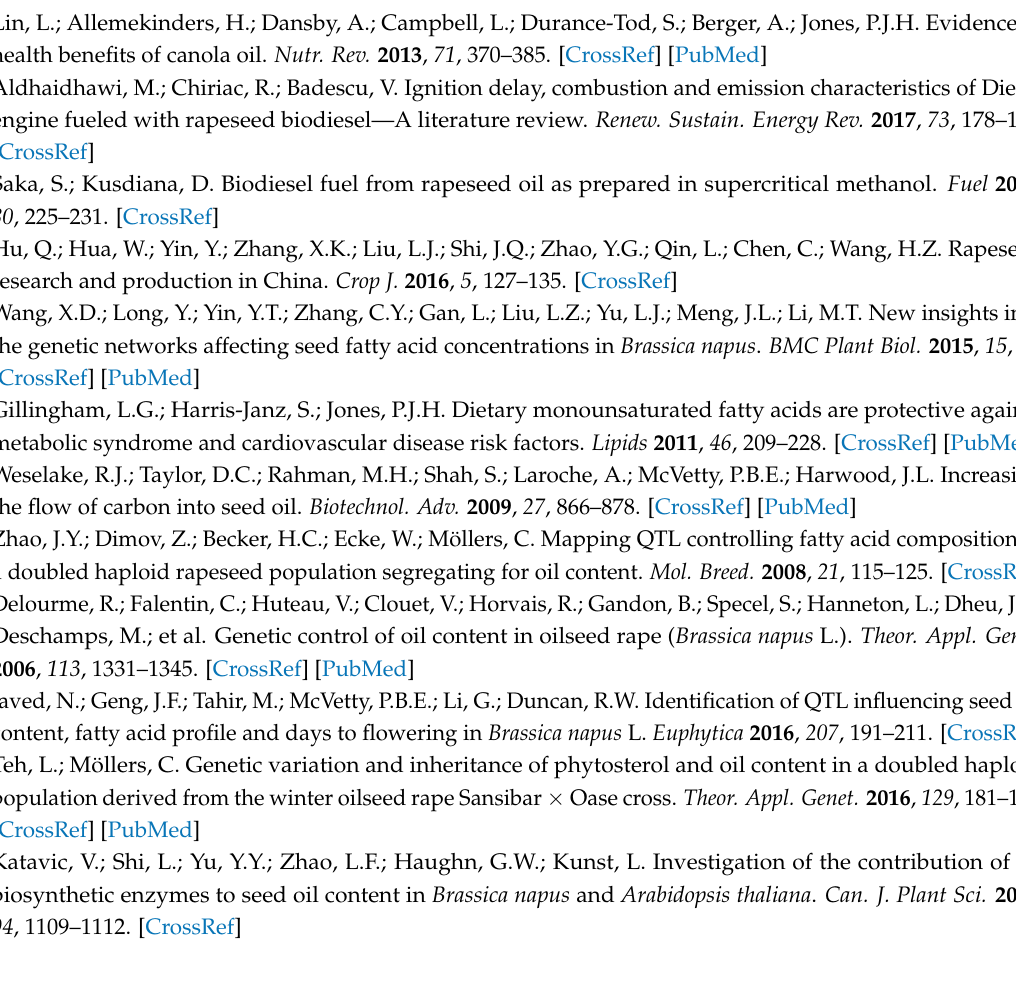
Figure S1: PCR analysis of putative transformants of GmDof4 , Figure S2: PCR analysis of putative transformants of GmDof11 , Figure S3: Homology of the accD gene promoters in B . napus and A . thaliana , Table S1: Amplification primers used for Semi-quantitative and quantitative RT-PCR, Table S2: Composition of the major fatty acids in GmDof4 and GmDof11 transgenic seeds, Table S3: the Dof genes in B . napus . Author Contributions: Y.W. designed the experiment, Q.S. and J.X. performed experiments, L.L. and